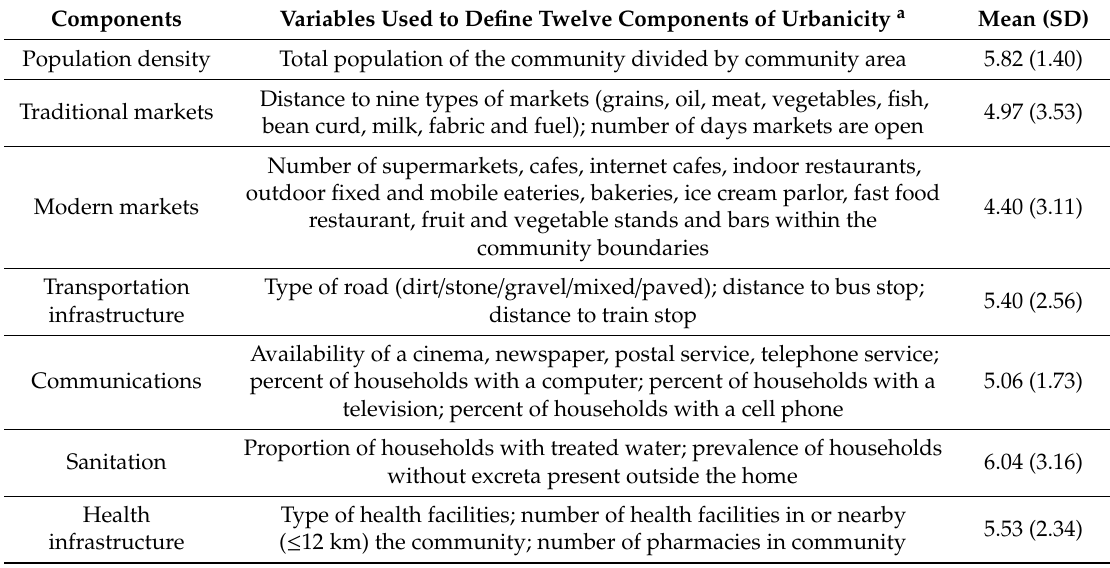
Table A1. Description of the twelve components of the urbanicity scale, China Health and Nutrition Survey